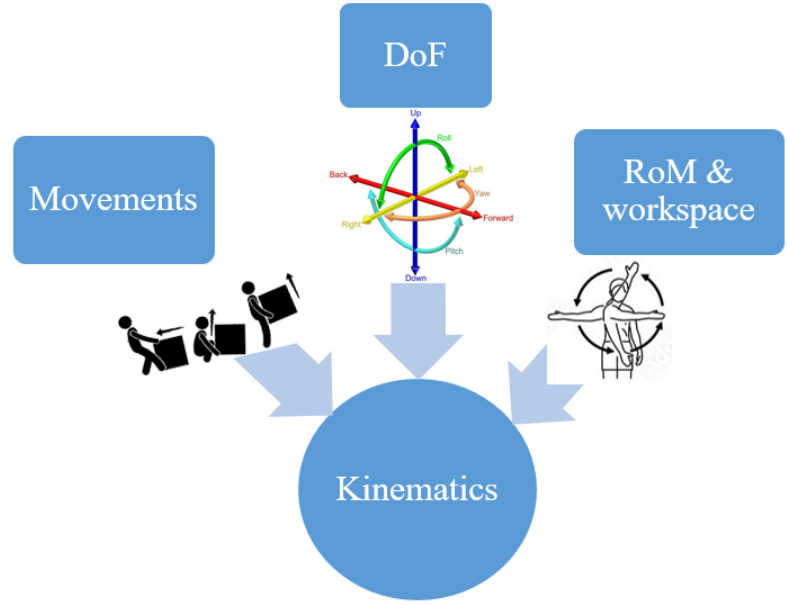
Figure 9. Kinematics requirements for exoskeletons in